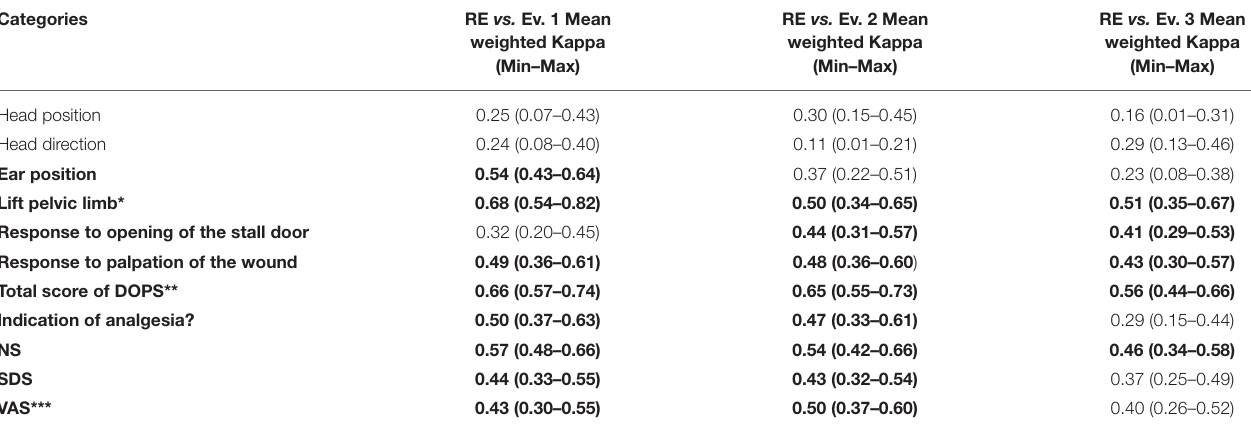
TABLE 8 | Reproducibility (inter-rater reliability) of the DOPS and unidimensional scales to evaluate pain in donkeys submitted to orchiectomy. Categories